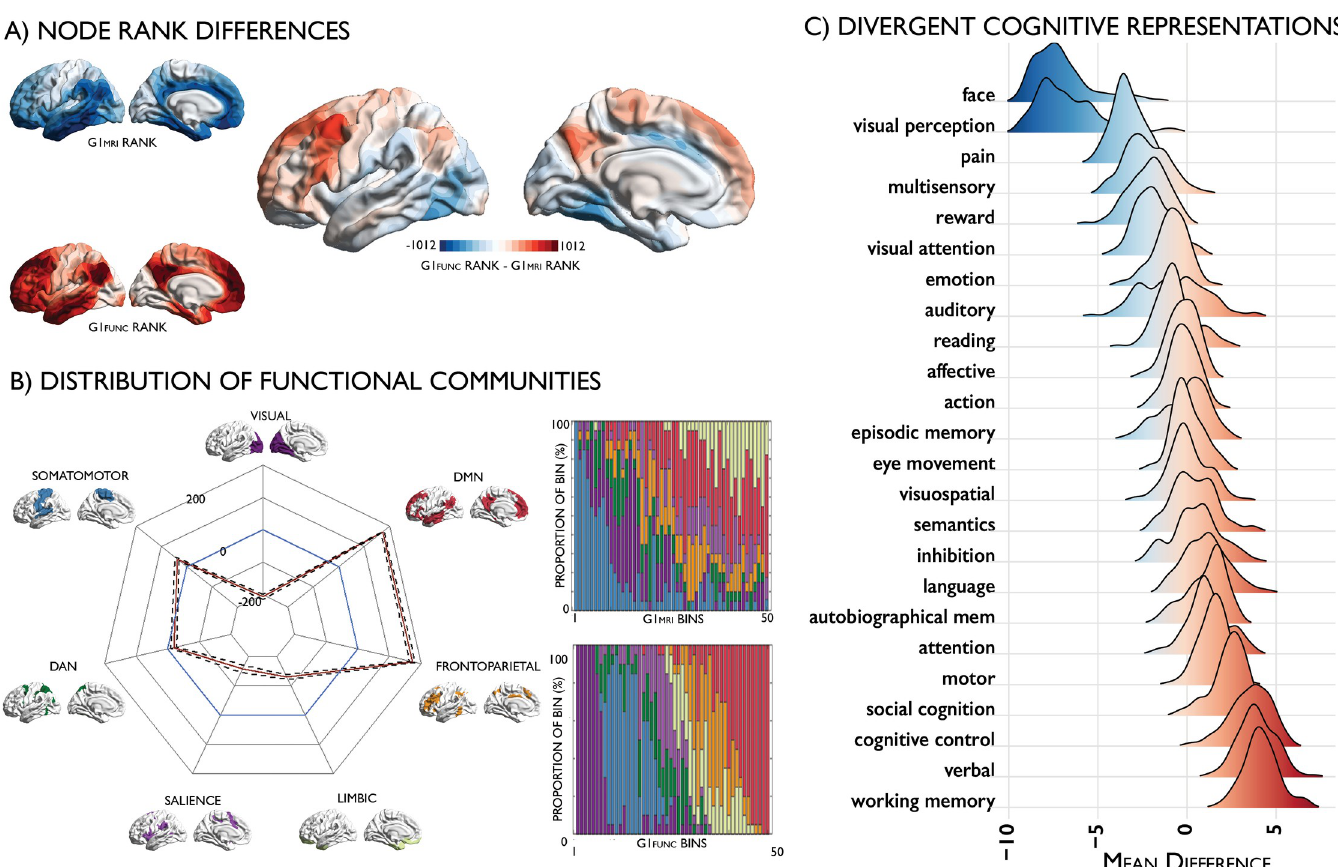
Fig 5. Divergent representations of the cortical hierarchy derived from microstructure and function. (A) Differences in nodal ranks between G1 MRI (blue) and G1 FUNC (red). (B) Radar plot depicting the difference in mean node ranks of functional communities [26] between G1 MRI (blue) and G1 FUNC (red), with 95% confidence intervals calculated across individuals presented with dotted lines; stacked bar plots depicting the proportion of each bin accounted for by intrinsic functional communities. (C) Meta-analysis maps for diverse cognitive terms were obtained from Neurosynth [28]. We calculated node-wise z-statistics, capturing node-term associations, and calculated the centre of gravity of each term along G1 FUNC and G1 MRI. The density plots depict the mean difference in the centre of gravity of meta- analysis maps in G1 FUNC and G1 MRI space across subjects. In vivo imaging data is openly available as part of the HCP S900 release (https://www.humanconnectome.org/ study/hcp-young-adult/document/900-subjects-data-release). FUNC, functional; GI, first principal gradient; HCP, Human Connectome Project; MPC, microstructure profile covariance; MRI, magnetic resonance